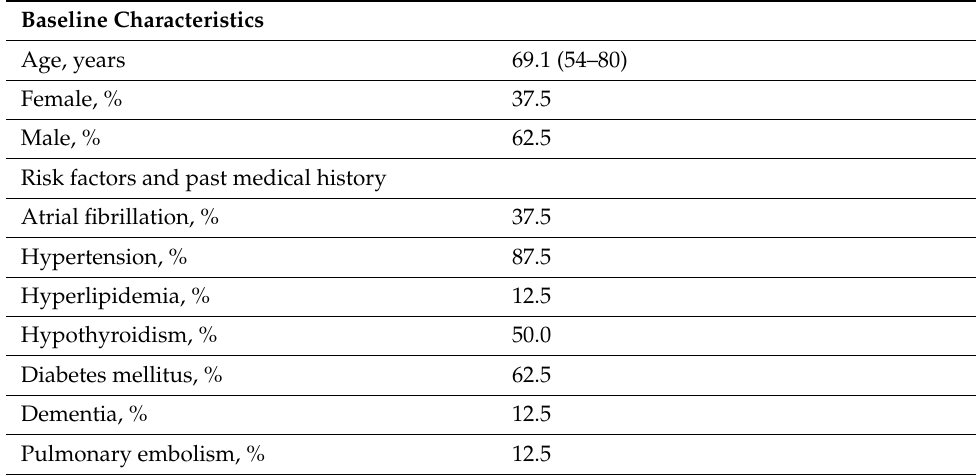
Table 1. Demographic characteristics of patients, cancer type, immune checkpoint inhibitor (ICI) treatment and cardiac